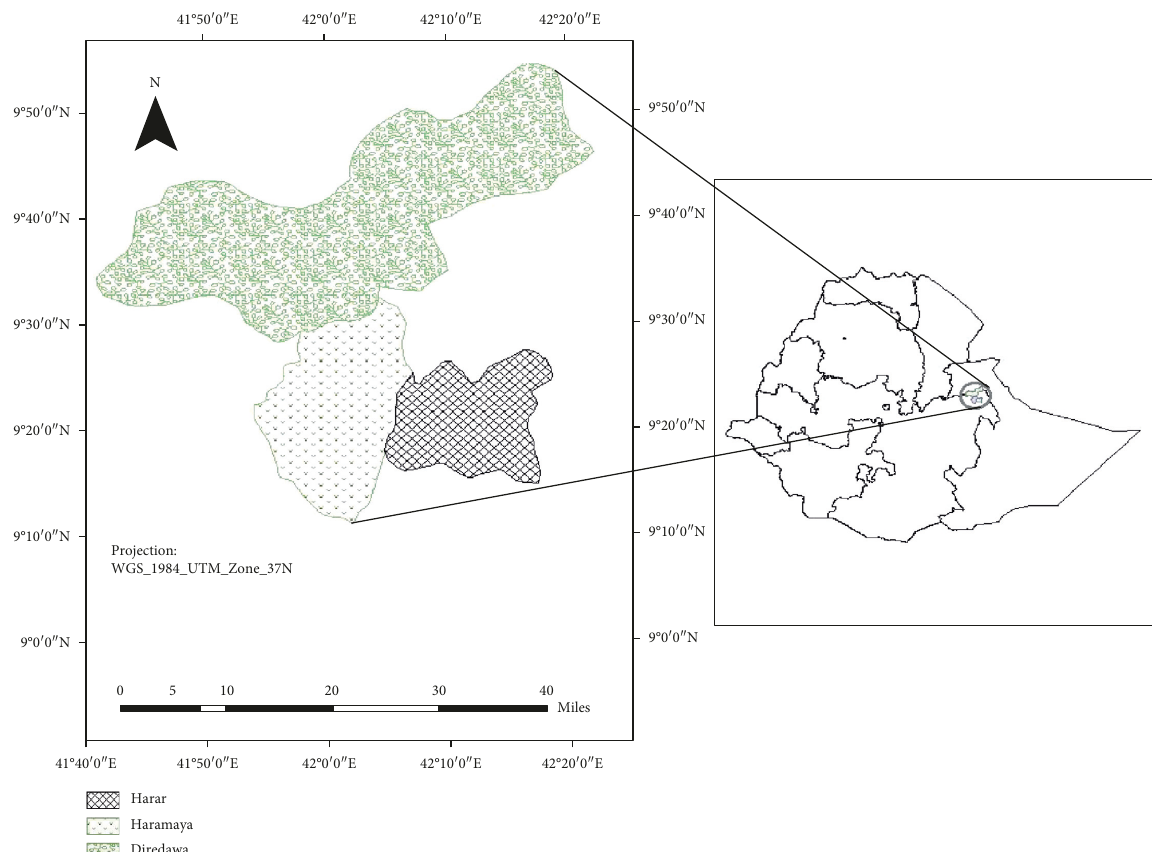
Figure 1: Map of the study area source